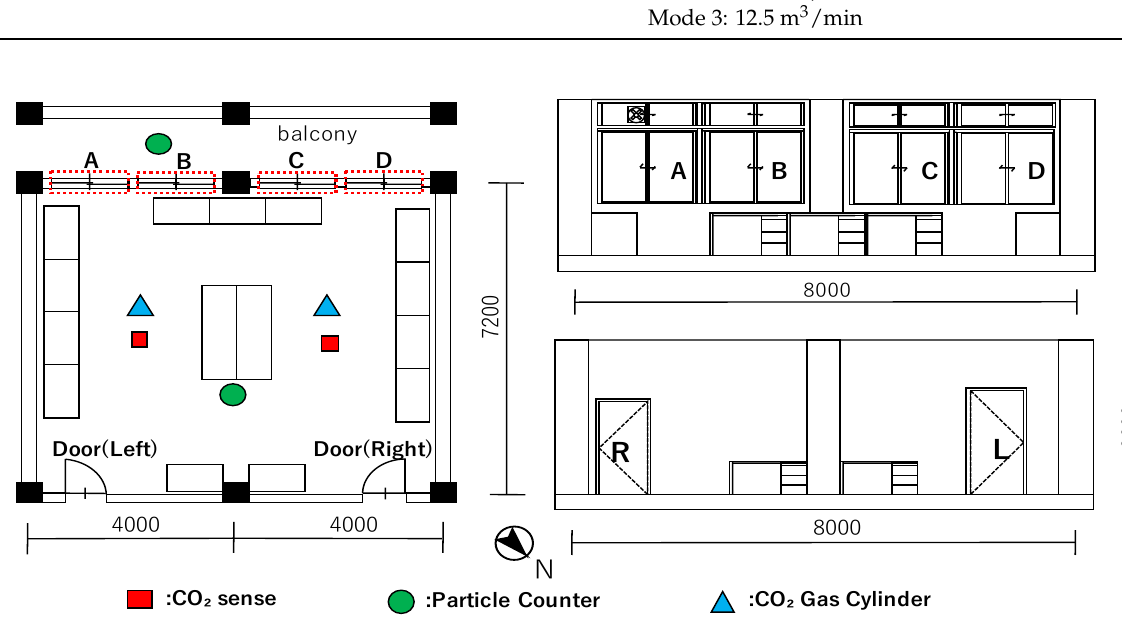
Figure 1. Floor plan and cross-section of the study room.